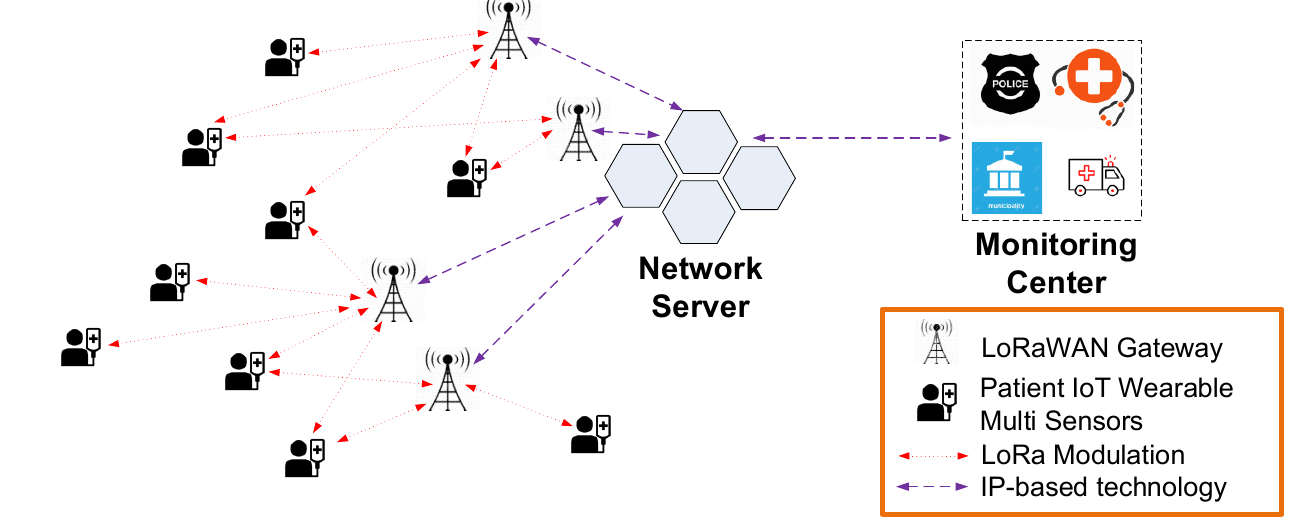
Figure 4. COVID-19 IoT multi-sensor patient monitoring architecture.